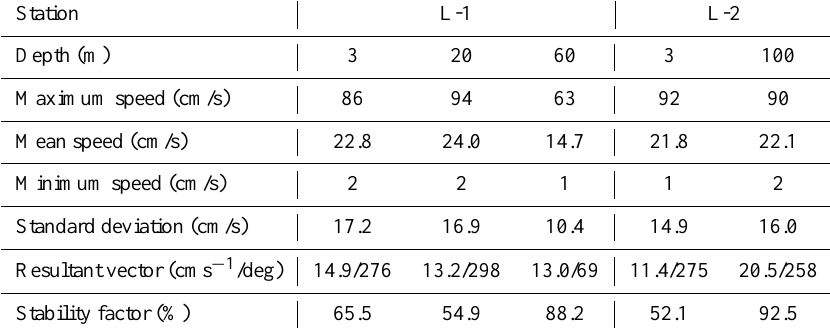
Table 1. Statistical description of currents measured at the stations L-1 (from 17 February to 6 March 1989) and L-2 (from 18 February to 5 March